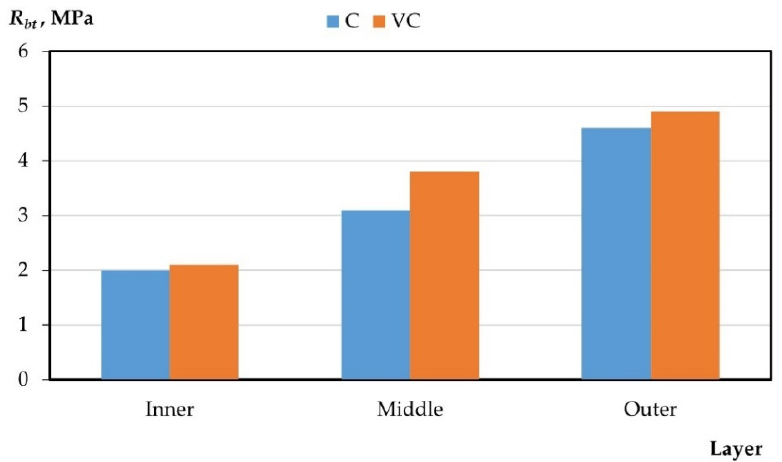
Figure 5. Change in axial compressive strength by layers (C—centrifuged concrete, VC—vibrocentrifuged concrete).